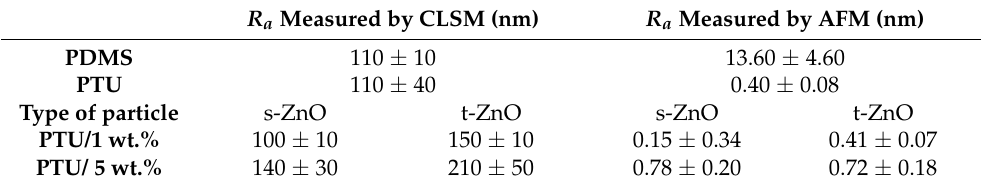
Table 1. Surface roughness ( R a ) of polymer variations containing 0 wt.%, 1 wt.% and 5 wt.% of t-ZnO and s-ZnO particles measured by confocal laser-scanning microscopy (CLSM) and atomic force microscopy